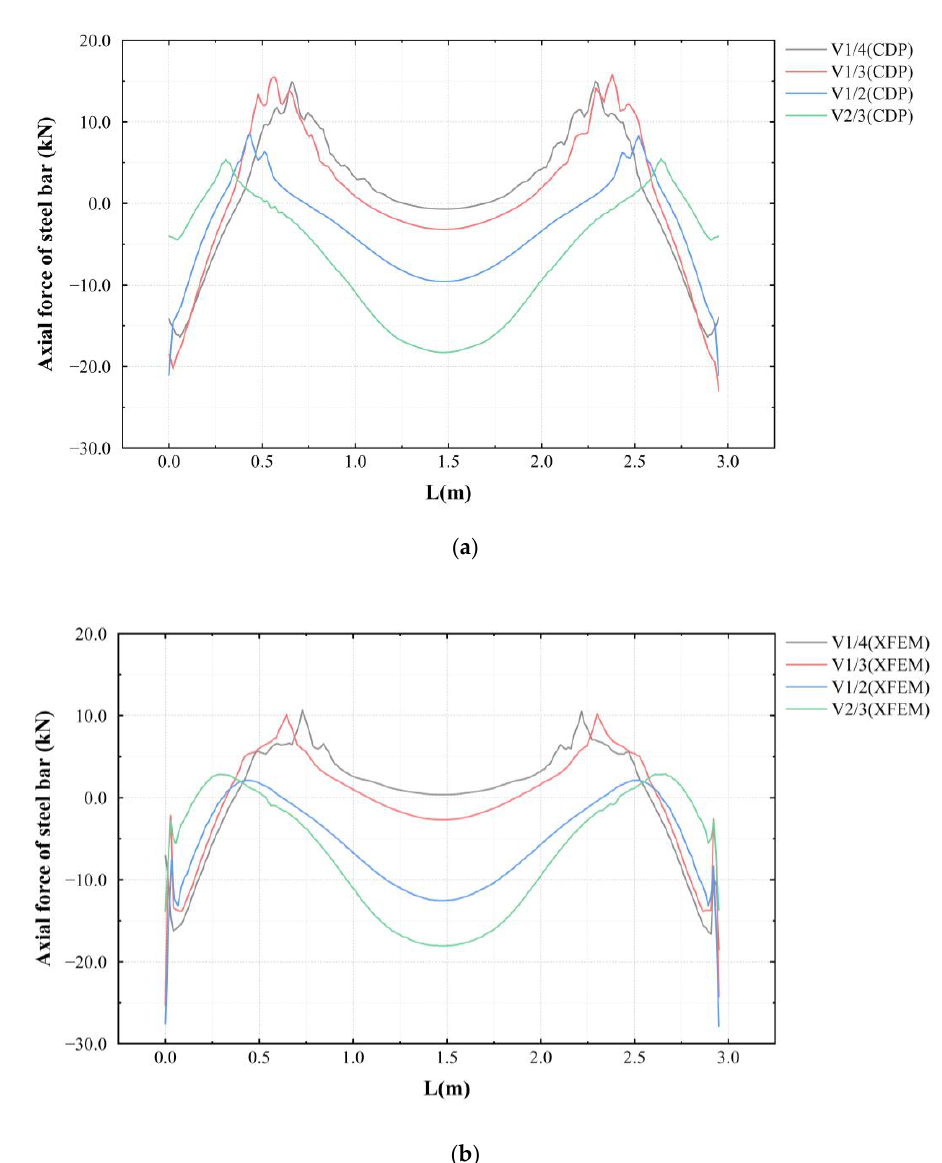
Figure 19. Stress of the lower rebars: ( a ) CDP and ( b ) XFEM.